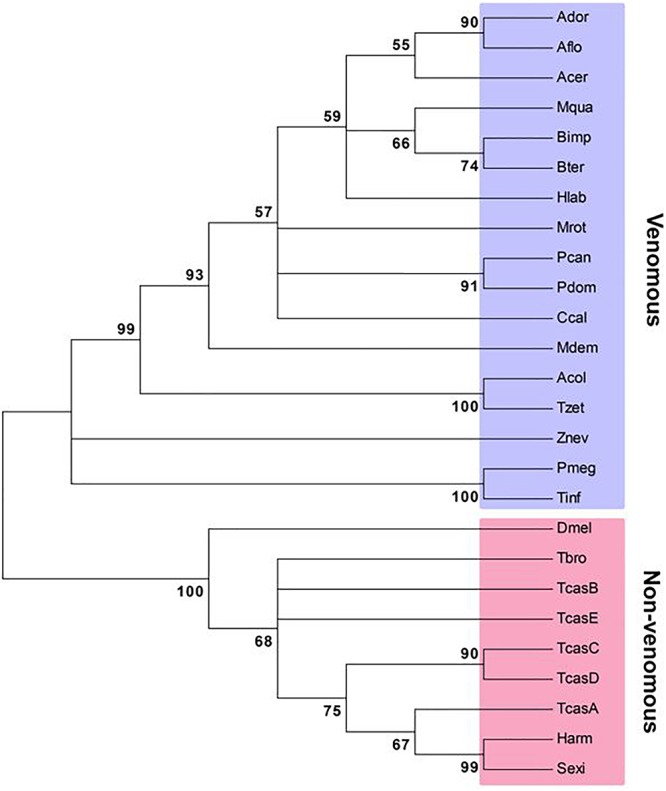
Phylogenetic analysis of venomous and non-venomous sPLA2s. The tree was constructed with Neighbor-joining method using MEGA6.0. Bootstrapping values on branches were obtained with 1,000 repetitions. Amino acid sequences were retrieved from GenBank. Accession numbers are PBC33208.1 for Apis cerana cerana (Acer), XP_006621273.1 for A. dorsata (Ador), XP_003694784.1 for A. florea (Aflo), KYM84159.1 for Atta colombica (Acol), XP_003491197.1 for Bombus impatiens (Bimp), XP_003400956.1 for B. terrestris (Bter), XP_017884585.1 for Ceratina calcarata (Ccal), KYM98685.1 for Cyphomyrmex costatus (Ccos), KOC68767.1 for Habropoda laboriosa (Hlab), XP_003699810.1 for Megachile rotundata (Mrot), KOX79218.1 for Melipona quadrifasciata (Mqua), JAC85837.1 for Panstrongylus megistus (Pmeg), XP_015172342.1 for Polistes dominula (Pdom), XP_014602740.1 for P. canadensis (Pcan), XP_011150082.1 for Harpegnathos saltator (Hsal), XP_008560296.1 for Microplitis demolitor (Mdem), NP_001014501.1 for Drosophila melanogaster (Dmel), XP_021189466.1 for Helicoverpa armigera (Harm), MH061374 for Spodoptera exigua (Sexi), JAI14574.1 for Tabanus bromius (Tbro), KYQ53077.1 for Trachymyrmex zeteki (Tzet), JAS01512.1 for Triatoma infestans (Tinf), NP_001139389.1 for Tribolium castaneum A (TcasA), NP_001139390.1 for TcasB, NP_001139461.1 for TcasC, NP_001139342.1 for TcasD, XP_966735.2 for TcasE, and XP_021915493.1 for Zootermopsis nevadensis (Znev).